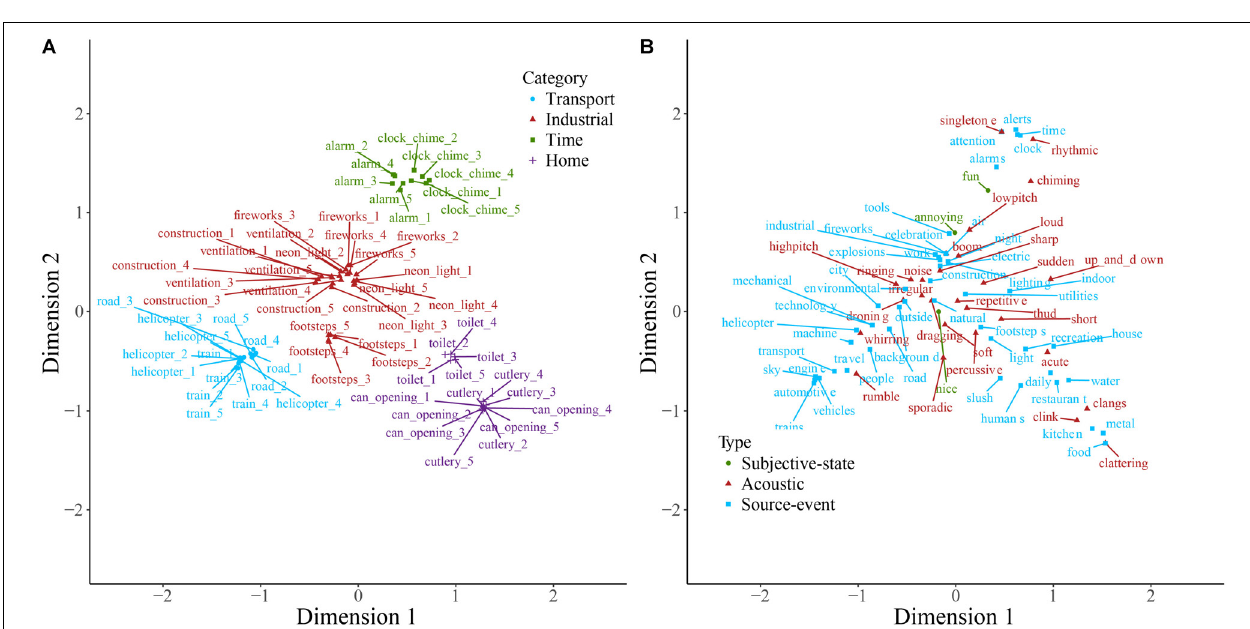
FIGURE 2 | Nature sounds (A) and descriptive words (B) plotted on the first two dimensions of categorization data. Note that the dimensions are the same in both panels. Sounds (A) are colored according to which of the main categories they belong to, and descriptive words (B) are colored according to type. Labels are displaced from their corresponding data point, indicated by a connecting line, to avoid overlapping.